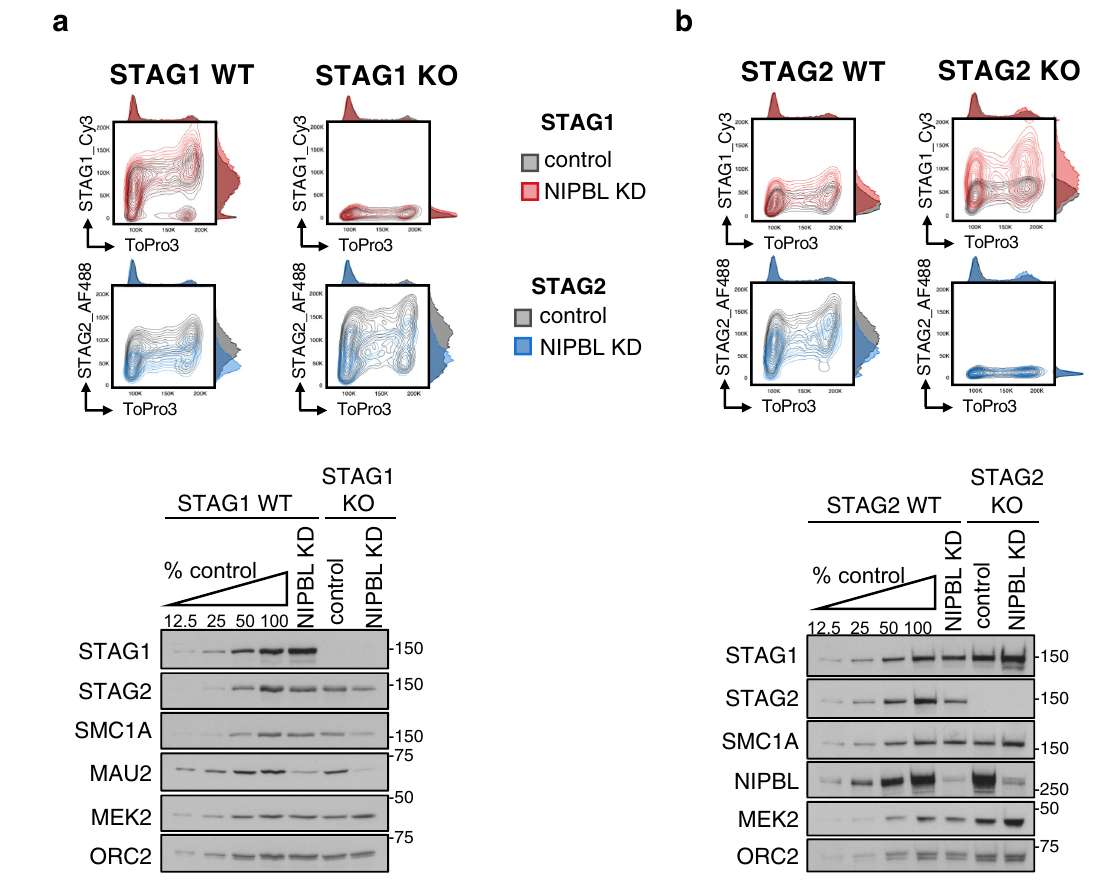
Fig. 3 | NIPBL KD increases cohesin on chromatin in STAG2 KO cells. a Top, contour plot pro fi les of chromatin-bound STAG1 and STAG2 in A673 cells with (WT) or without (KO) STAG1 in control (gray) and NIPBL KD (colored)